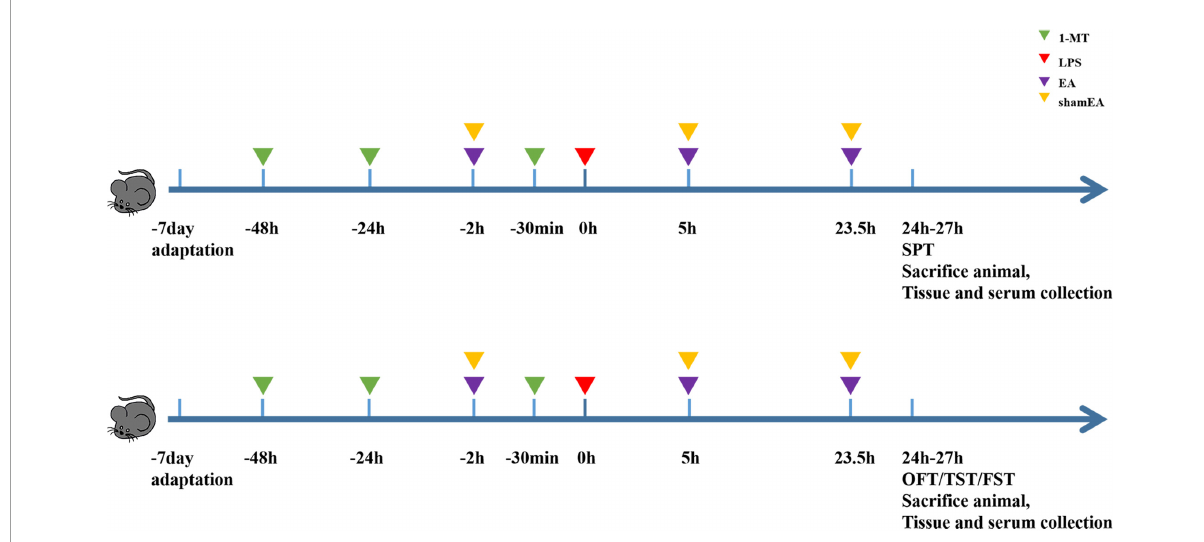
FIGURE1 Experimental design scheme. Mice were acclimated for 7 days and received the administration of 1-MT (15 mg/kg, i.p.) before 48 h, 24 h, and 30 min of administrating LPS (0.83 mg/kg, i.p.); electroacupuncture and sham electroacupuncture treatment were performed once before LPS injection and repeated 5 and 23.5 h after LPS injection; behavior tests were done at 24–27 h after LPS. Each group contains four behavior tests as follows: sugar preference, open fields, forced swimming, and suspension of the